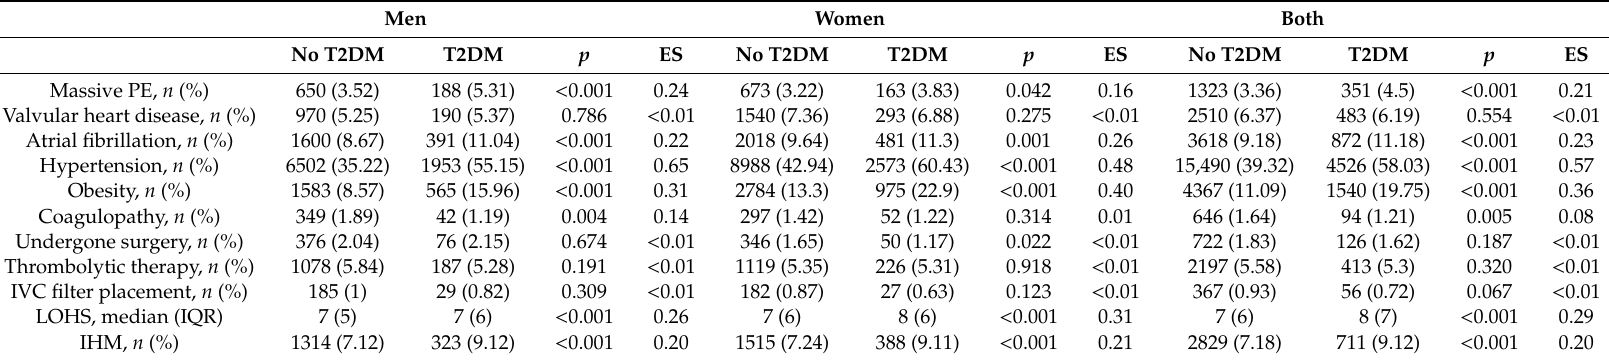
Table 2. Prevalence of specific comorbid conditions, procedures and in-hospital outcomes among patients hospitalized with pulmonary embolism (PE) according to sex and type 2 diabetes (T2DM) status in Spain